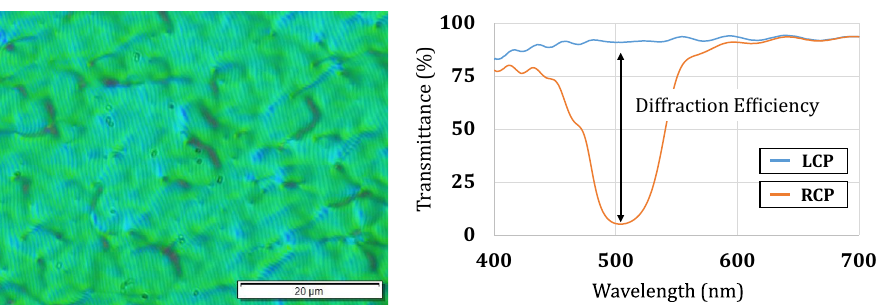
Figure 7. Optical characteristics of the fabricated PSD. We present a microscope image of the PSD, which demonstrates the randomized grating property that gives diffusive optical response to the incident light. The transmittance according to the polarization and the wavelength is measured to evaluate the selectivity given by the volume grating